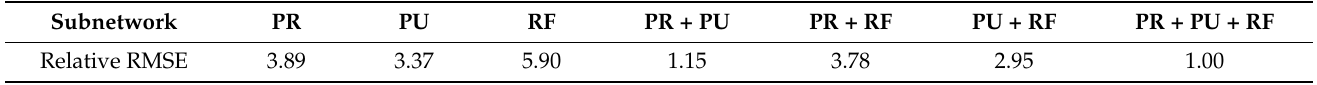
Table 3. Results of ablation studies of the subnetworks.